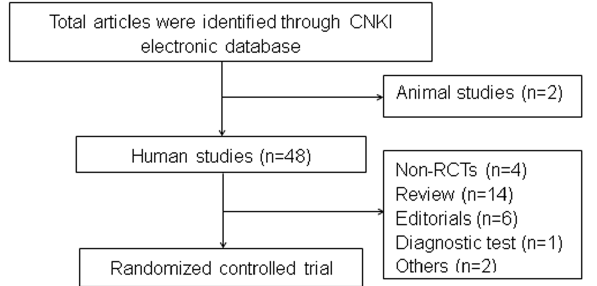
Table 3. The average reporting percentage for each section and the total of the CONSORT checklist in